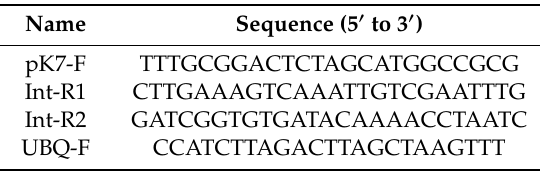
Table 3. List of primers used for the destination